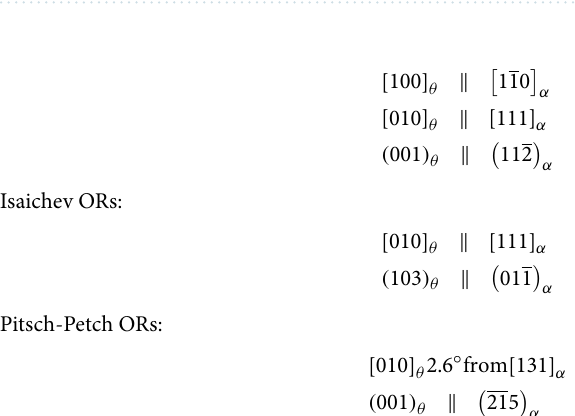
Table 1. Lattice constants of ferrite and